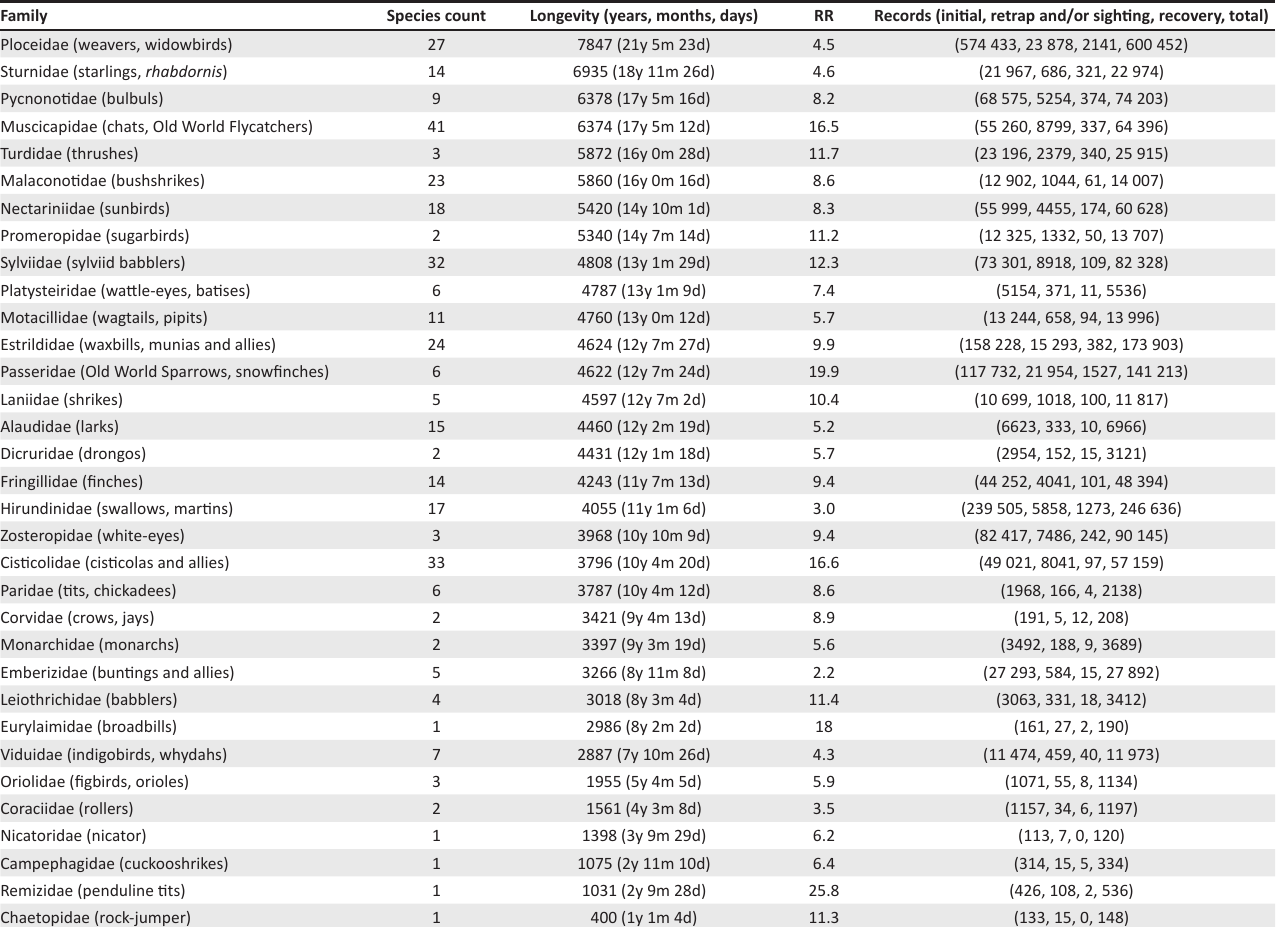
TABLE 1: Maximum longevity records curated by the South African Bird Ringing Unit for each of the southern African Passeriformes families. Family Species